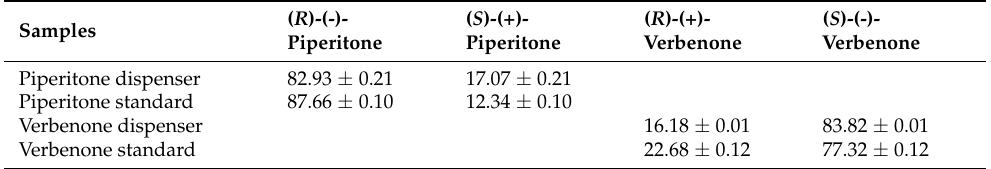
Table 2. Mean ( ± SE) enantiomeric composition of piperitone and verbenone in repellent dispensers and standard reference samples ( n = 3) using an Rt- β DEXse